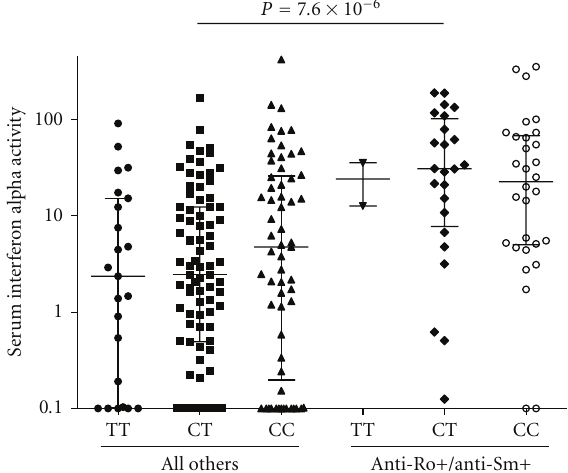
Figure 3: Serum IFN- α activity in African-American SLE patients stratified by rs3813065 genotype and presence or absence of the anti-Ro positive/anti-Sm positive serologic phenotype. Serum IFN- α is represented in relative units on the Y -axis, as described in Methods. “Anti-Ro+/Anti-Sm+” indicates SLE patients who have positive tests for both anti-Ro and anti-Sm, and “All others” indicates all of the other SLE patients who lack one or both of these autoantibodies. Line drawn at the median and error bars show the interquartile range. P value by Mann-Whitney U test for a di ff erence between subjects with CT genotype with versus without the anti-Ro+/anti-Sm+